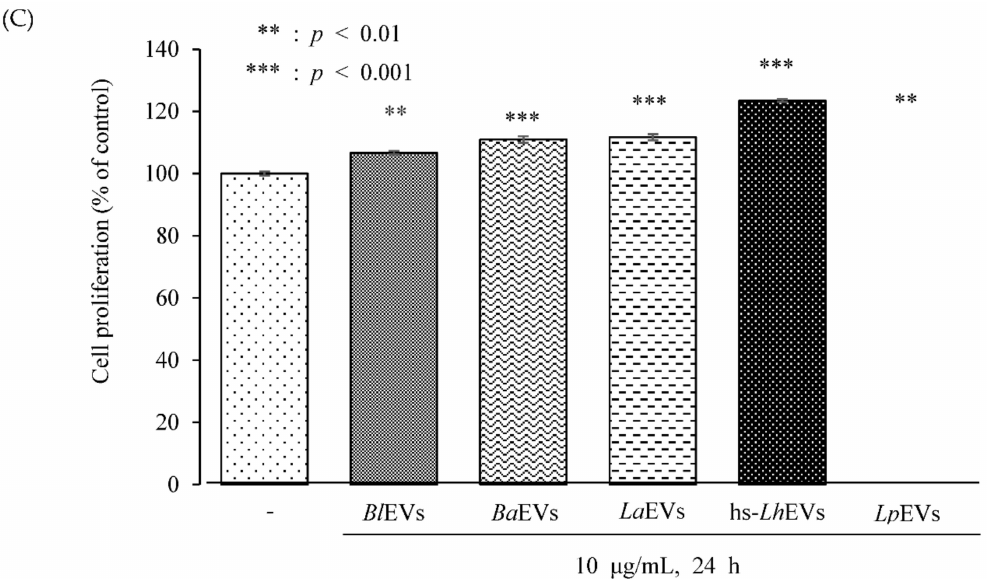
Figure 3. Cell migration and proliferation inductive effects of PB-EVs in human follicle dermal papilla cells (HFDPCs). ( A ) Cell migration as determined by a wound healing assay, treated with 10 µ g/mL of Bl EVs, Ba EVs, La EVs, Lh EVs, or Lp EVs for 24 h. ( B ) Quantification of migrated cells shown in ( A ). ( C ) Cell proliferation as assessed with CCK-8-based assay performed on HFDPCs treated with 10 µ g/mL of PB-EVs. Mean ± SD of experiments are shown. ** p < 0.01; *** p < 0.001—Student’s t -test was used. Bl EVs, Bifidobacterium longum -derived extracellular vesicles; Ba EVs, Bifidobacterium animalis -derived extracellular vesicles; La EVs; Lactobacillus acidophilus -derived extracellular vesicles; hs- Lh EVs, extracellular vesicles derived from Leuconostoc holzapfelii isolated from the human scalp; Lp EVs, Lactobacillus plantarum -derived extracellular vesicles.